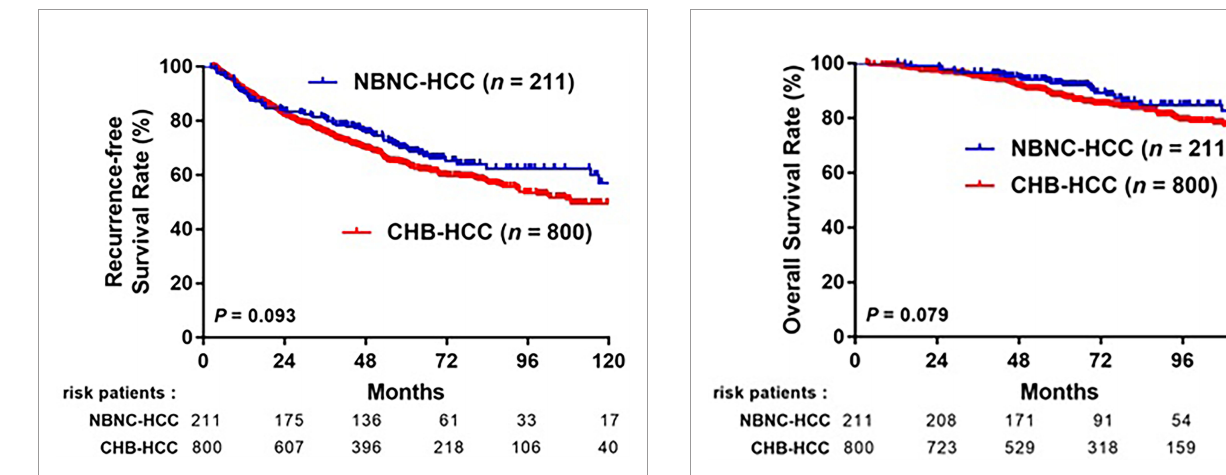
FIGURE 4 | Comparison overall survival (OS) after curative resection between patients with CHB-HCC and